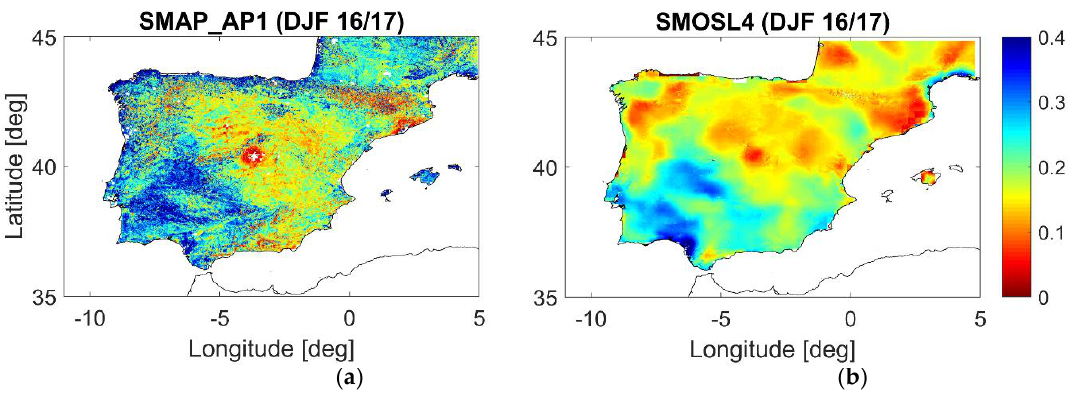
Figure 4. Temporally-averaged map of daily SMAP ( a ) and SMOS ( b ) products at 1 km over the Iberian Peninsula for the period December 2016 to February